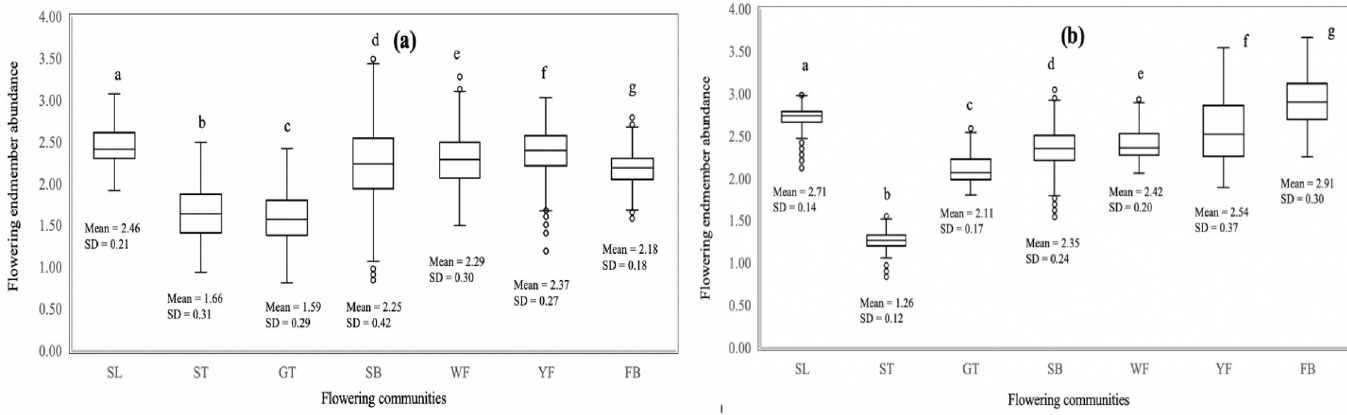
Fig 5. Box plots distribution of the flowering endmember abundancy of the flowering vegetation communities. Endmember standard deviation (SD) and means are shown for each of the flowering vegetation communities during the onset of flowering in January 2014 (a) and peak flowering season in February 2013 (b). Box plots with different letter(s) are significantly different from each other according to the Duncan’s test ( p ≦ 0 . 05 ).The circles show outliers.